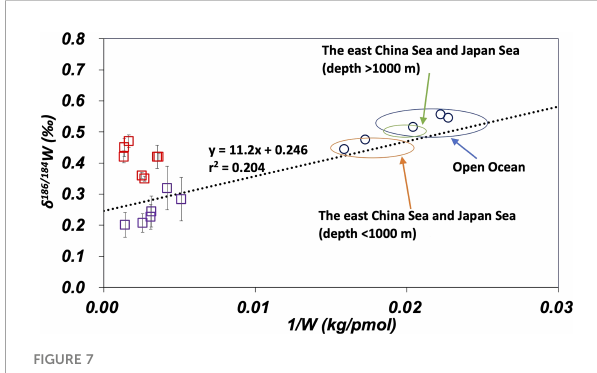
FIGURE 7 Comparison of W data of this study with literature on the plot of d 186/184 W vs. 1/W. The dotted line is the regression line (eq. 4) for the open ocean and marginal seas data. The error bar shows a standard deviation ( ± 1sd). Purple squares: Osaka Bay, red squares: the Yangtze River estuary (Yang et al., 2022), and blue circles: the South China Sea (Kurzweil et al.,